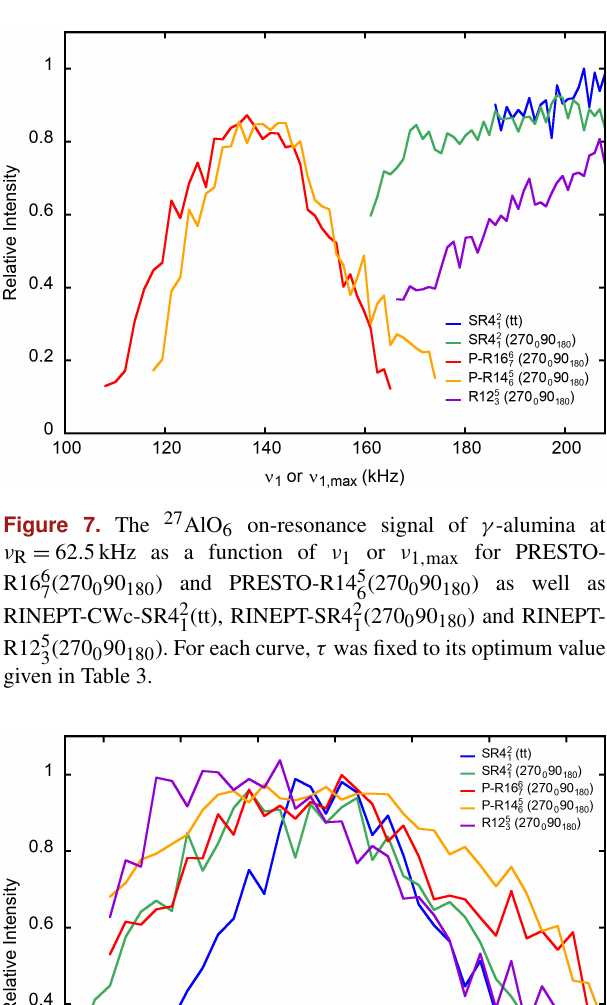
(270 0 90 180 ) and PRESTO- 7 (tt), RINEPT- 1 (270 0 90 180 ). For each curve, 3